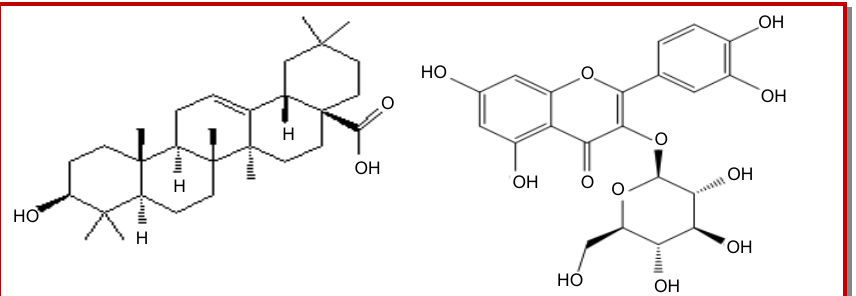
Figure 2: Structure of compound 1 (oleanolic acid, left) and compound 2 (isoquercetin,